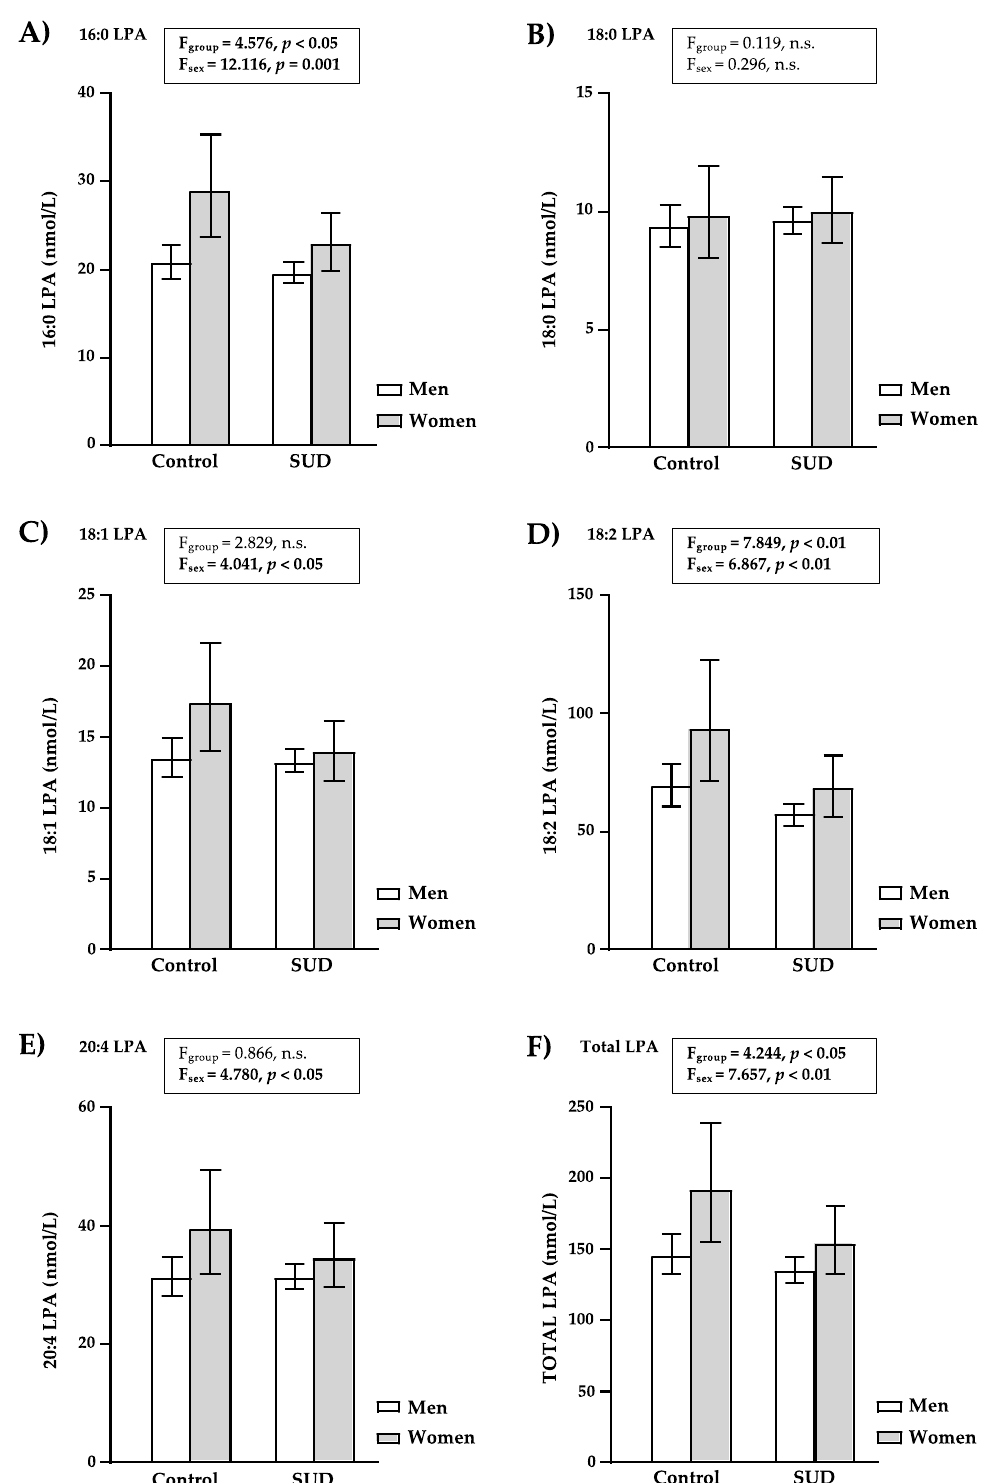
Figure 1. Plasma concentrations of LPA species and total LPA in the sample based on the sample group and sex factors. ( A ) 16:0-LPA concentrations; ( B ) 18:0-LPA concentrations; ( C ) 18:1-LPA concen- trations; ( D ) 18:2-LPA concentrations; ( E ) 20:4-LPA concentrations; and ( F ) total LPA concentrations (nmol/L). Log10-transformed concentrations of LPA species and total LPA were analyzed using two-way ANCOVA with sample group (SUD and control) and sex (women and men) as factors while controlling for age and BMI. The bars represent the estimated marginal means and 95% CI after back-transformation. F-statistics and p -values of ANCOVA are shown. (n.s.) p > 0.05 denotes no significant